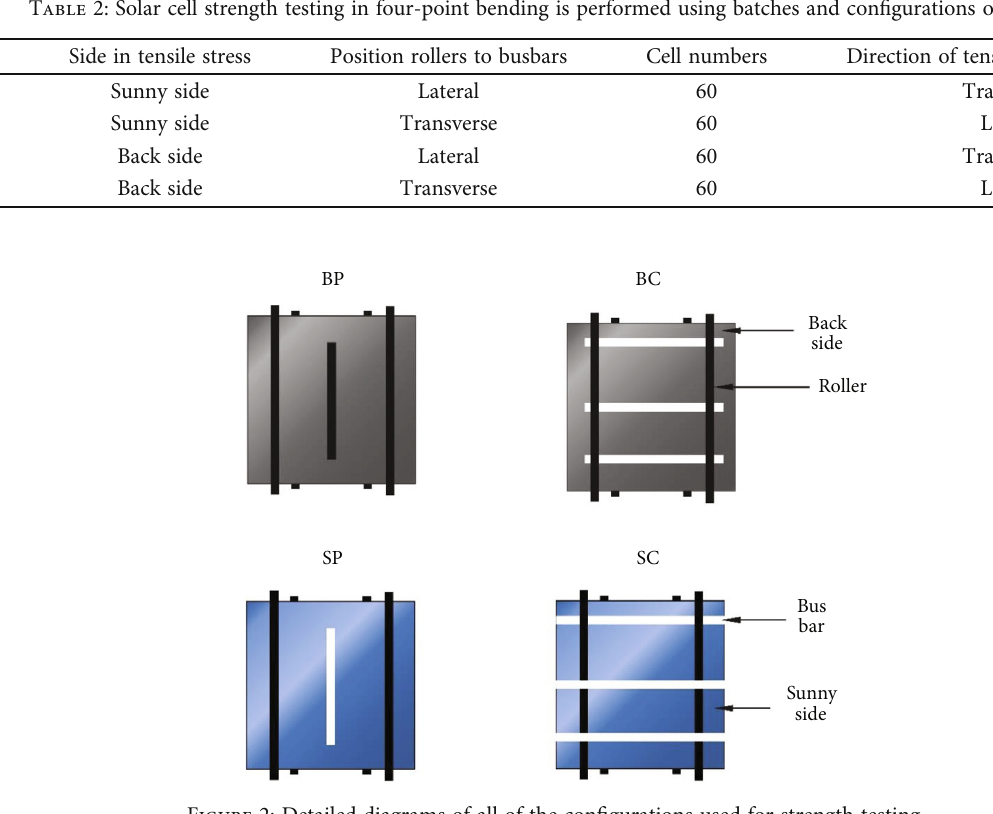
Figure 2: Detailed diagrams of all of the con fi gurations used for strength